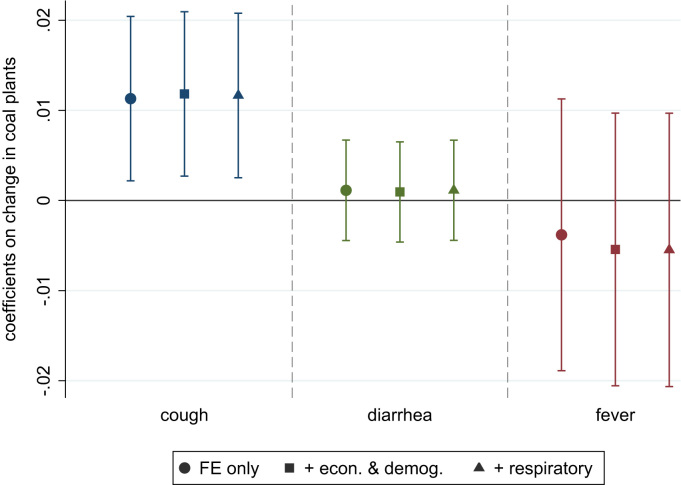
Main result: Difference-in-difference estimates of effect of coal plants on cough and on falsification outcomes. Figure plots coefficients on the count of coal plants. Each of the nine coefficients is from a separate regression where indicators for the reported symptoms listed (cough, fever, diarrhea) are the dependent variables. Each regression includes a survey round fixed effect and household fixed effects, so the graph studies change over time within households. Economic and demography controls: log of consumption per capita, urban residence, household size (count of persons) Respiratory controls: indicators for cooking fuel type, for use of cow dung, for whether the household has a separate kitchen or cooks outside, and for whether the household has electricity; the number of hours of electricity reported per day. Data: India Human Development Survey I (2005) and II (2012). Error bars are 95% confidence intervals using clustered standard errors. n=79,968 observations of change over these seven years for 39,984 households.